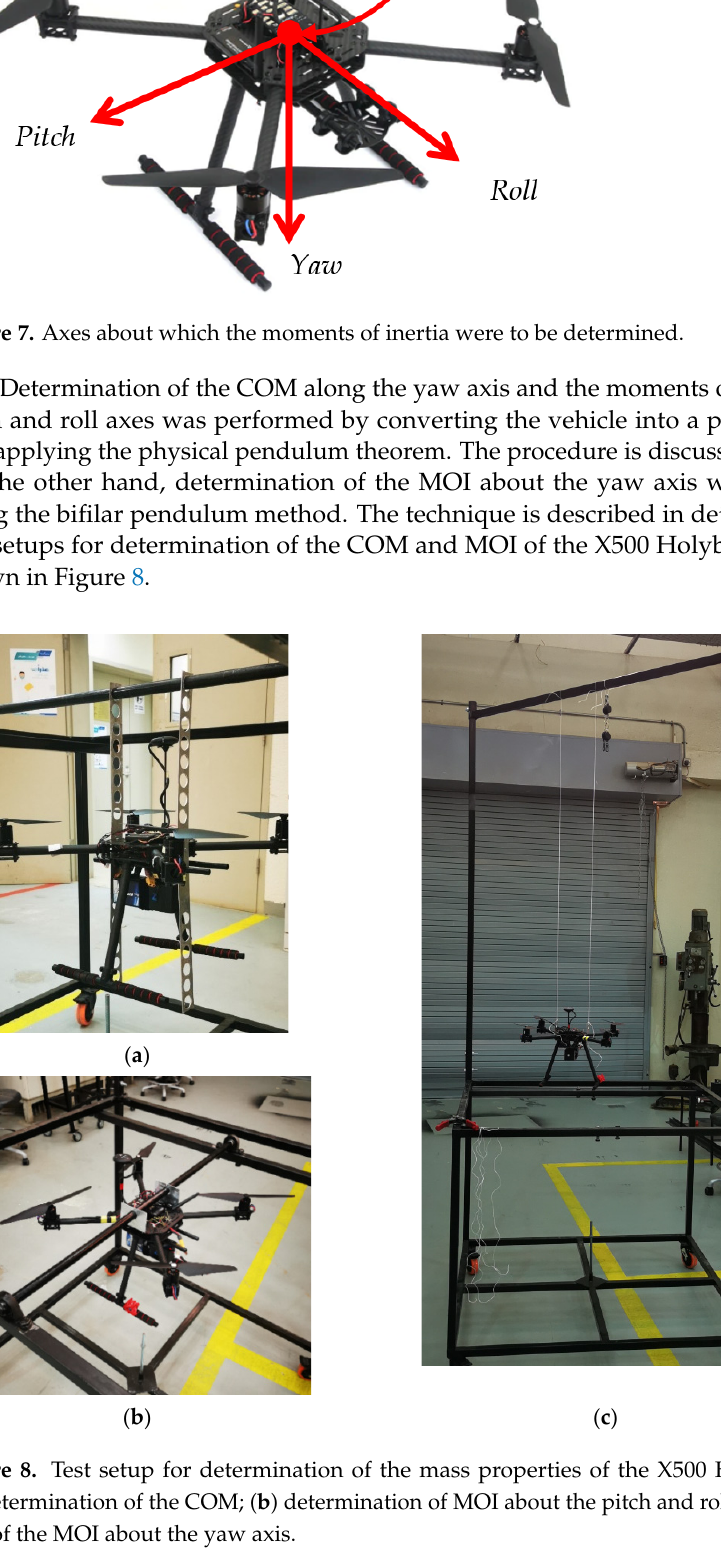
Figure 8. Test setup for determination of the mass properties of the X500 Holybro quadcopter: ( a ) determination of the COM; ( b ) determination of MOI about the pitch and roll axes; ( c ) determination of the MOI about the yaw axis.